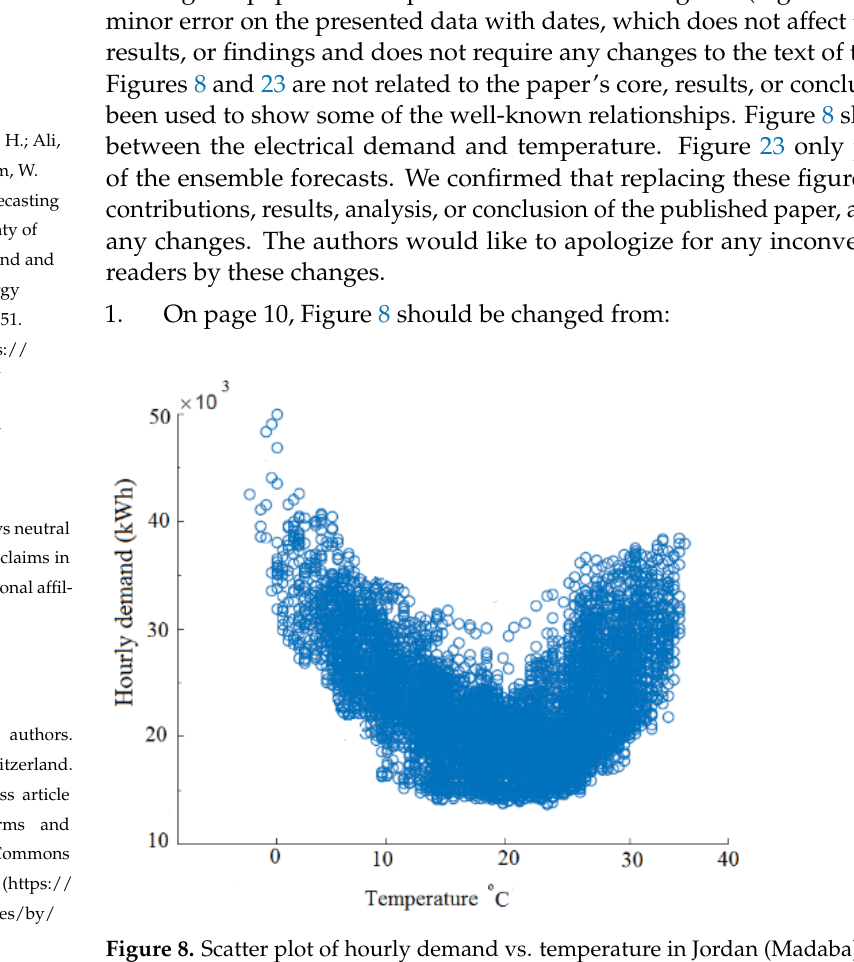
Figure 8. Scatter plot of hourly demand vs. temperature in Jordan (Madaba).